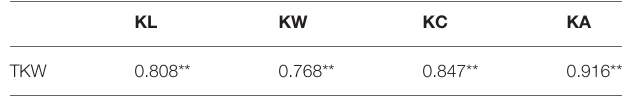
TABLE 6 | The coefficient of correlation of TKW with KL, KW, KC, and